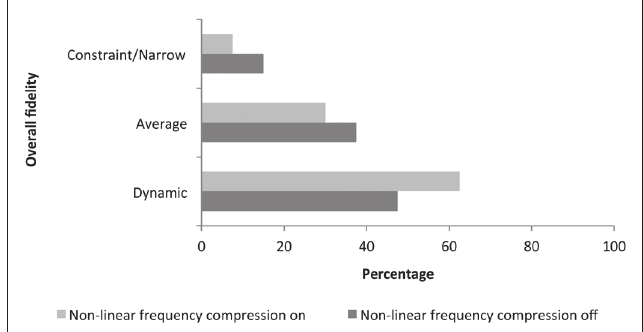
Fig. 6. Participants’ perception of the overall fidelity of music with NFC off versus NFC on.